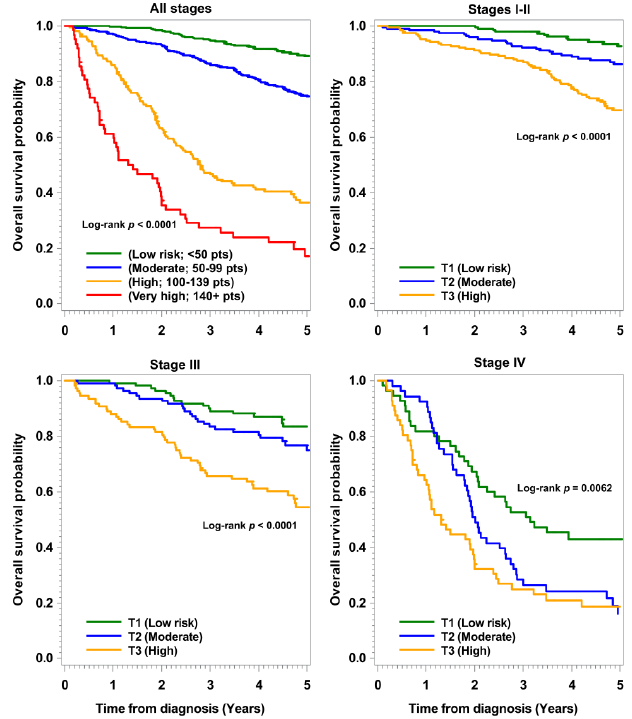
Figure 2. Overall survival stratified by nomogram risk groups in the validation set. T, tertile of total nomogram points.